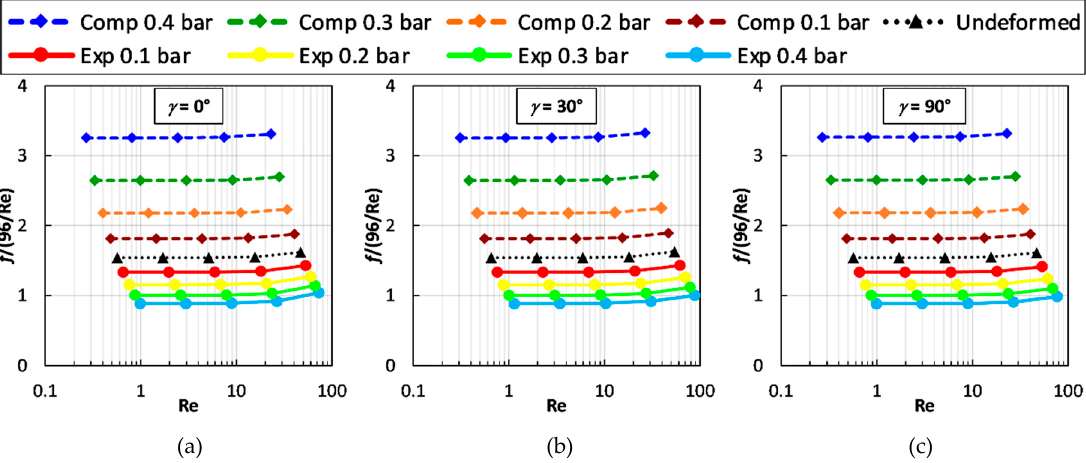
Figure 9. Darcy friction coefficients ( F ratio) for P / H = 10 as a function of the Reynolds number for different values of transmembrane pressure and three values of flow attack angle γ . ( a ) γ = 0°; ( b ) γ = 30°; ( c ) γ = 90°.